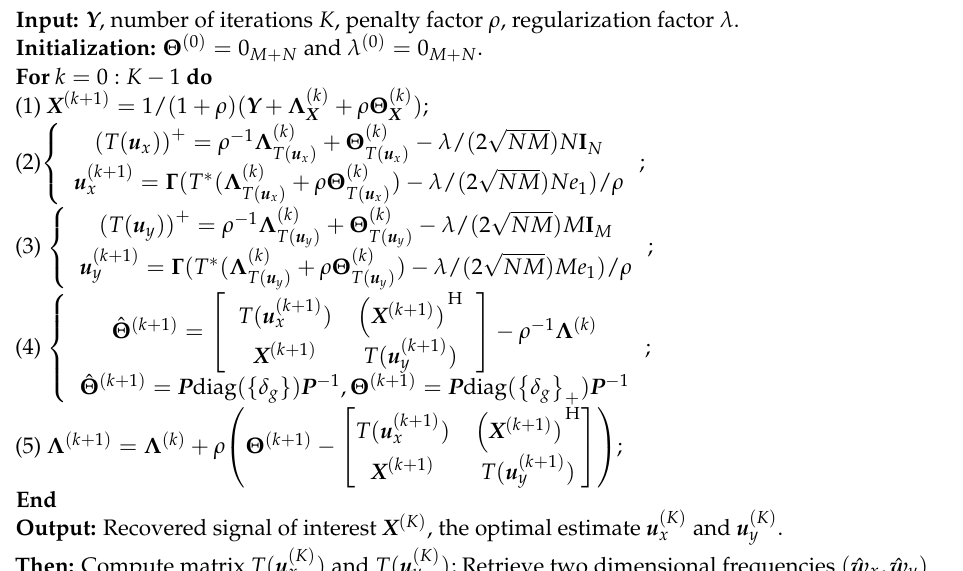
Algorithm 2: DANM-ADMM DOA